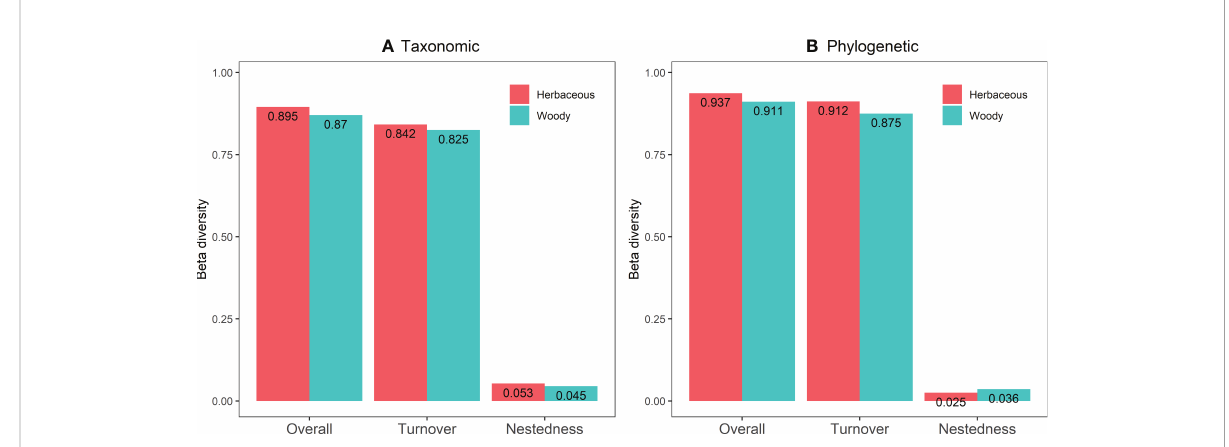
FIGURE 5 The taxonomic (A) and phylogenetic (B) b -diversity and its composition of the herbaceous and the woody community in the arid and semiarid areas of China.